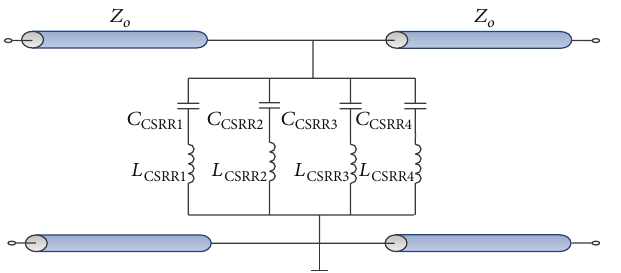
Figure 14: Circuit model of a transmission line loaded with CSRR.